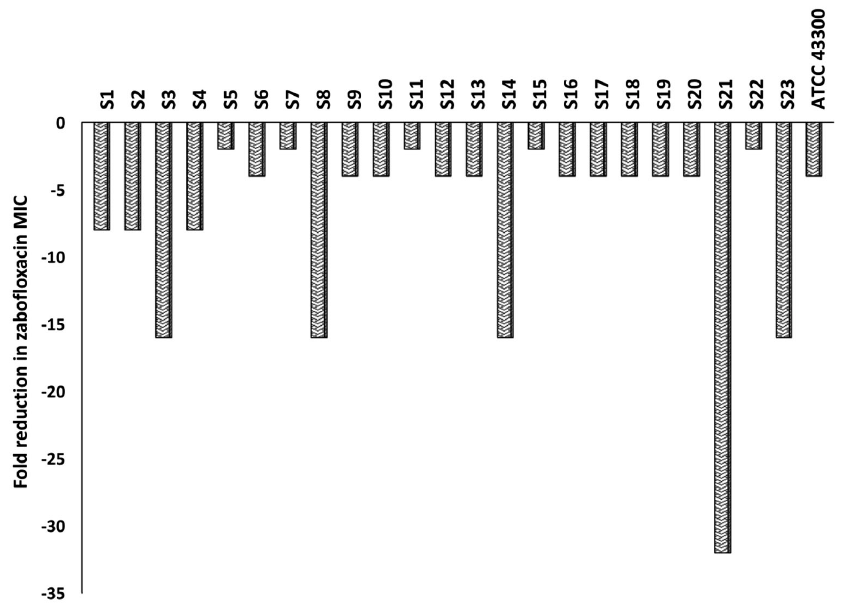
Fig. 2. Fold reduction in zabofloxacin MIC when combined with 16µg/ml of caspofungin tested against MRSA clinical isolates, S1 to S23, and the standard MRSA, ATCC